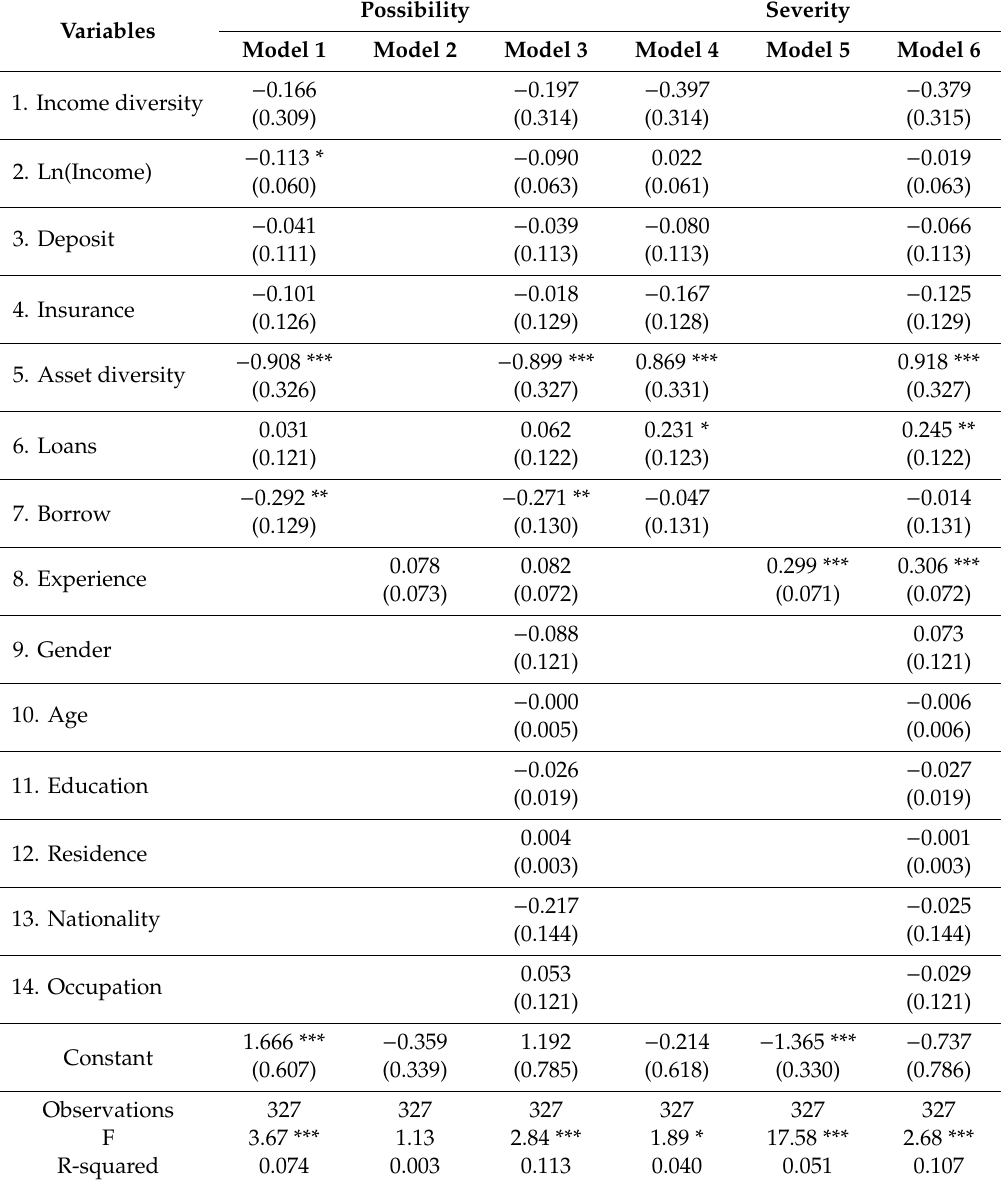
Table 5. Regression results of rural households’ financial preparation, disaster experience, and risk